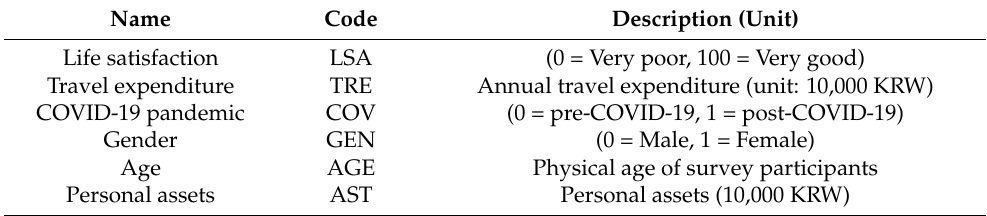
Table 1. Variable description.